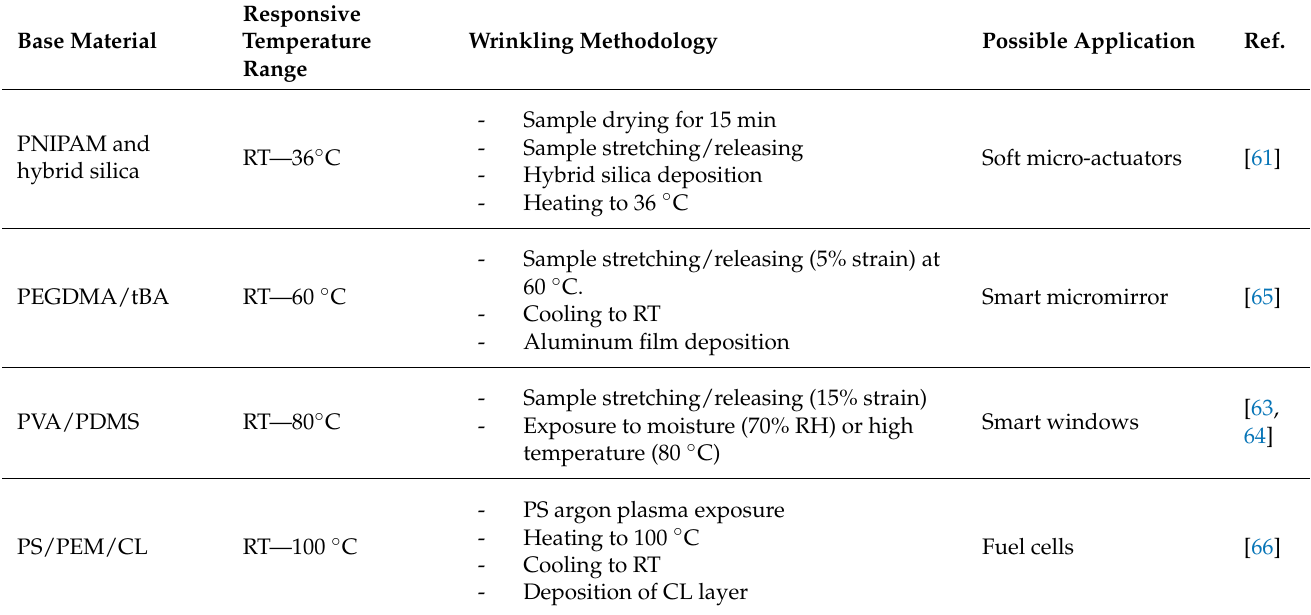
Table 3. Summary of thermo-sensitive materials listed in Section